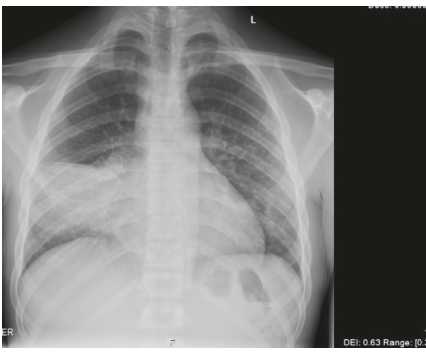
Figure 1: CXR AP frontal view on the day of admission showing right middle lobe